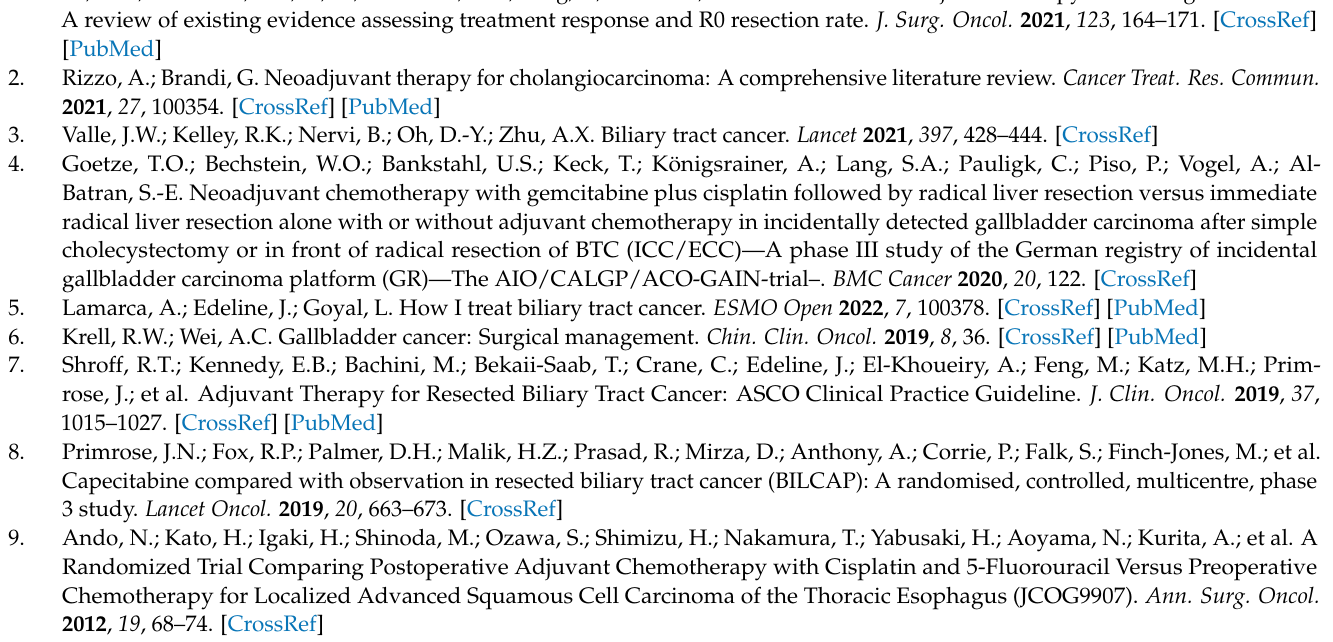
Table S1: Univariate and multivariate Cox regression analyses with OS and CSS among patients with extrahepatic biliary tract cancer before propensity score matching; Table S2: Patient characteristics after propensity score matching stratified by neoadjuvant therapy. Table S3: Patient characteristics after propensity score matching among patients with stages III/IVA of the disease; Table S4: ECC patient characteristics after propensity score matching stratified by neoadjuvant